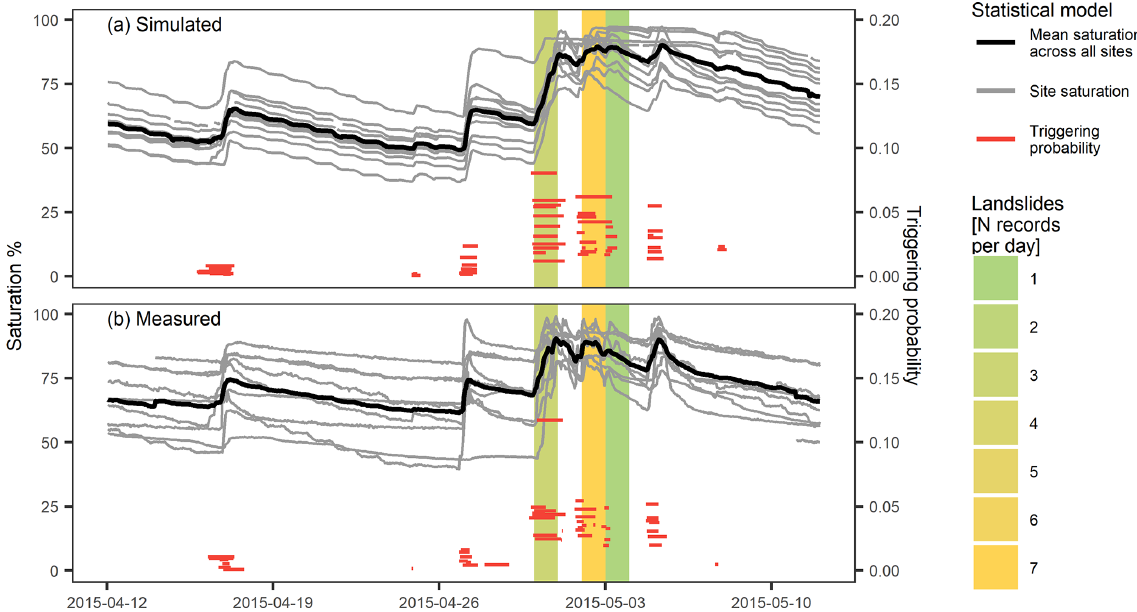
Figure 3. Profile saturation (grey lines) of a selection of 11 sites in central Switzerland (as depicted in Fig. 1b), with the mean profile saturation across all selected sites (black line), during a period of increased landslide activity in April and May 2015 for (a) simulated (lower boundary with groundwater and soil hydrological properties from SoilGrids) and (b) measured soil moisture. The colour-filled background denotes days with observed landslide events within 15km of any of the sites, with the colour indicating the number of landslide records. The red lines show the associated landslide triggering probability from the statistical model (based on the nine infiltration event properties listed in Table 2) at each site, which was computed for periods of saturation increase only.